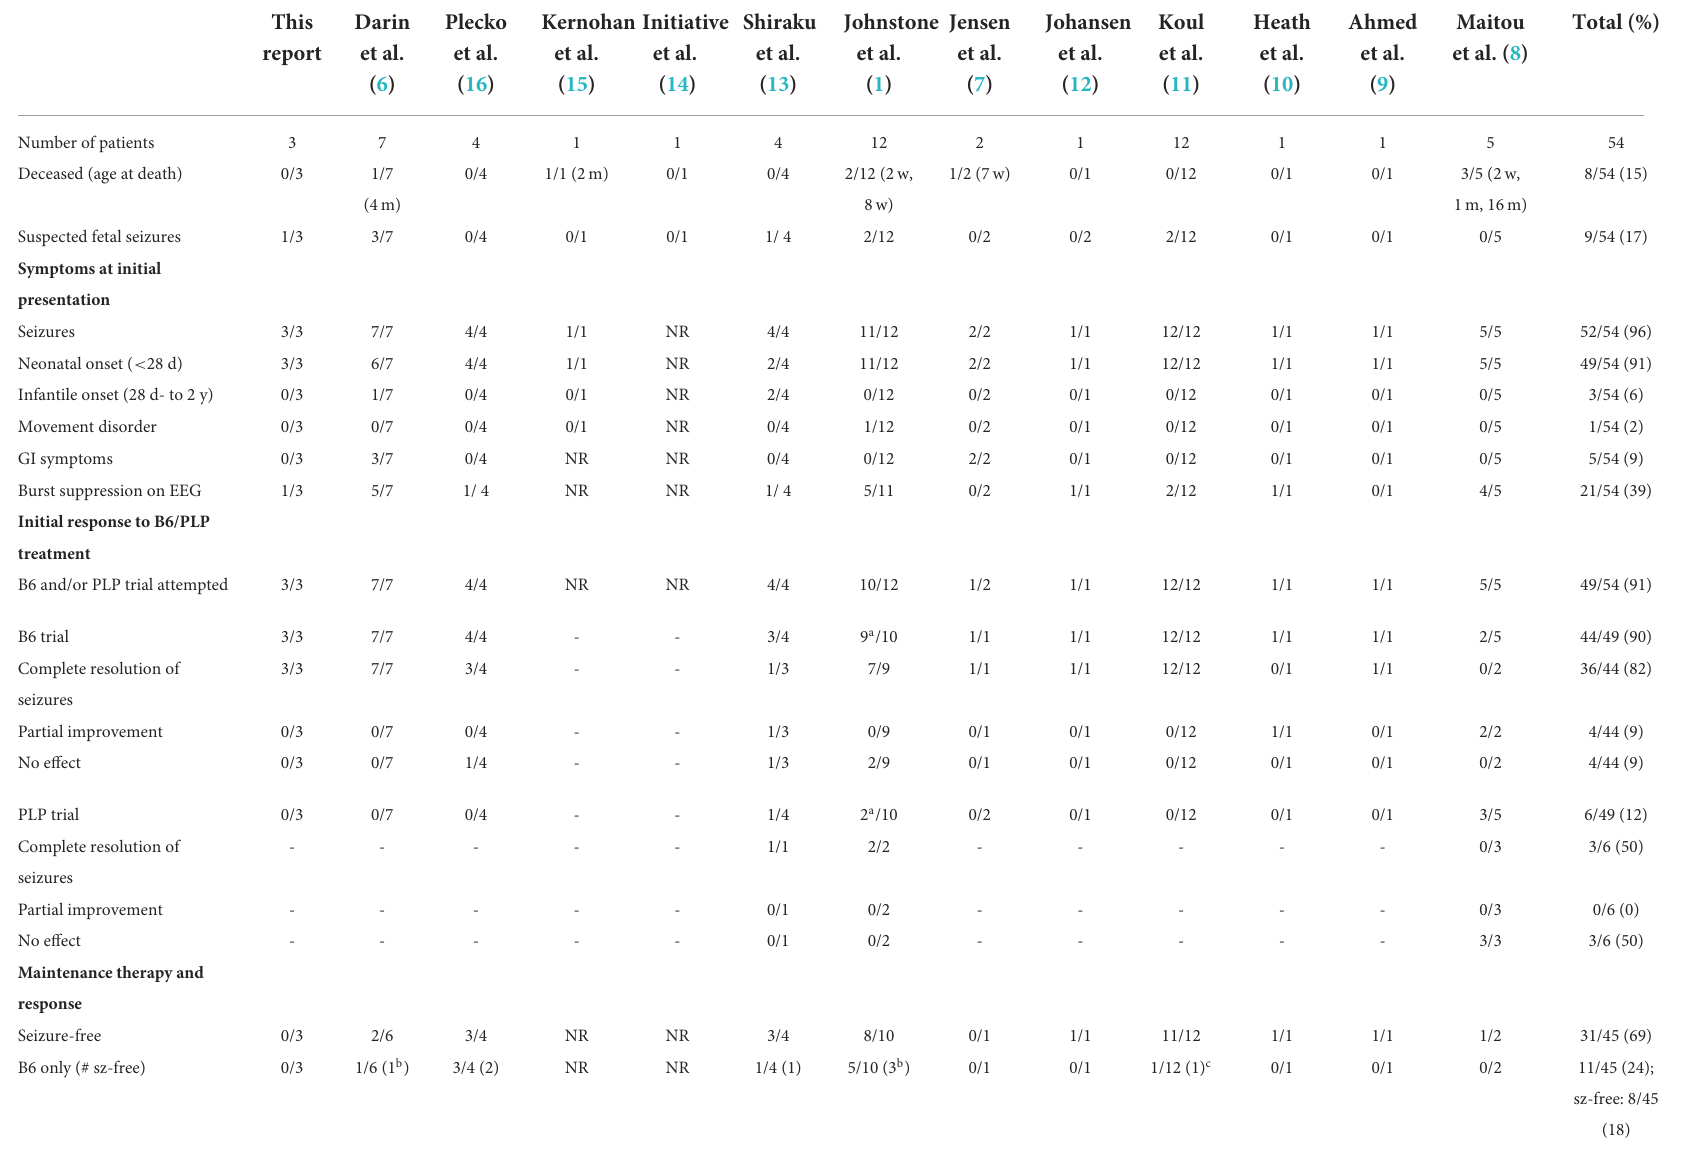
TABLE 1 Summary of clinical features in individuals with PLPBP pathogenic